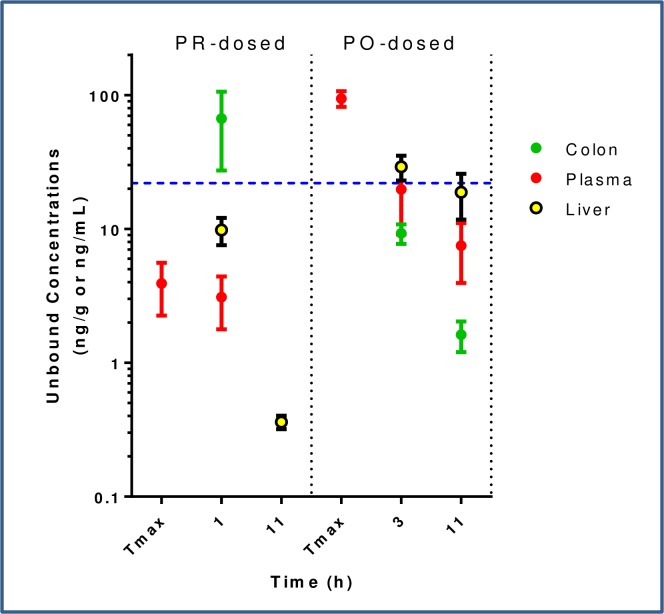
Unbound concentration (ng/mL for plasma; ng/g for colon and liver) of 1 over time after 30 mg/kg PO or PR dosing.The cellular EC50 corrected for binding in 10% FBS (22 ng/mL) is represented by the horizontal dotted blue line. Tmax = plasma Tmax.